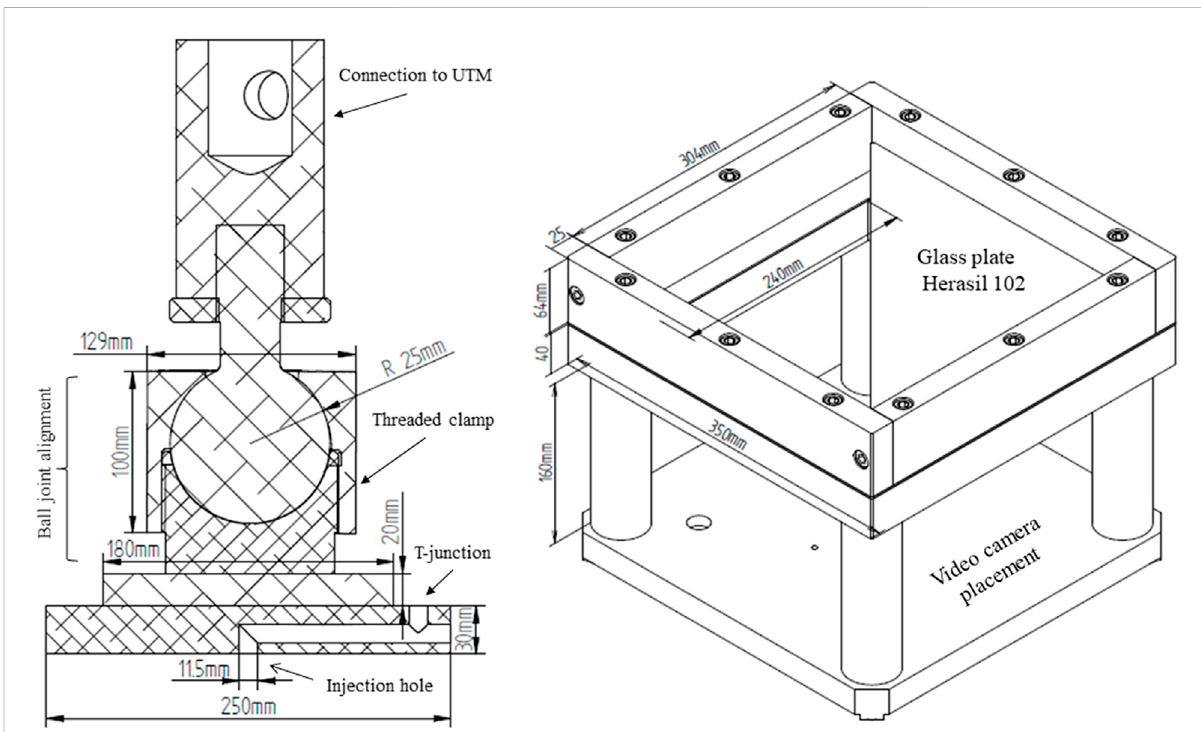
FIGURE 1 Upper assembly: Cut-out in the center of the compaction plate and ball join alignment. The compaction plate, a round plate 250 mm wide, 30 mm thick, contains the injection hole drilled in the center of the plate and a channel drilled inside the plate to connect with the injection system. Lowerassembly:The glassplateisplaced onasupporting framewith dimensions 350× 350 mm,with acut-outofdimensions 250×250 mm inthe center to visualize the fl ow front progression with a digital camera. The glass plate is held in place by aluminum plates 25 mm wide screwed intro the supporting